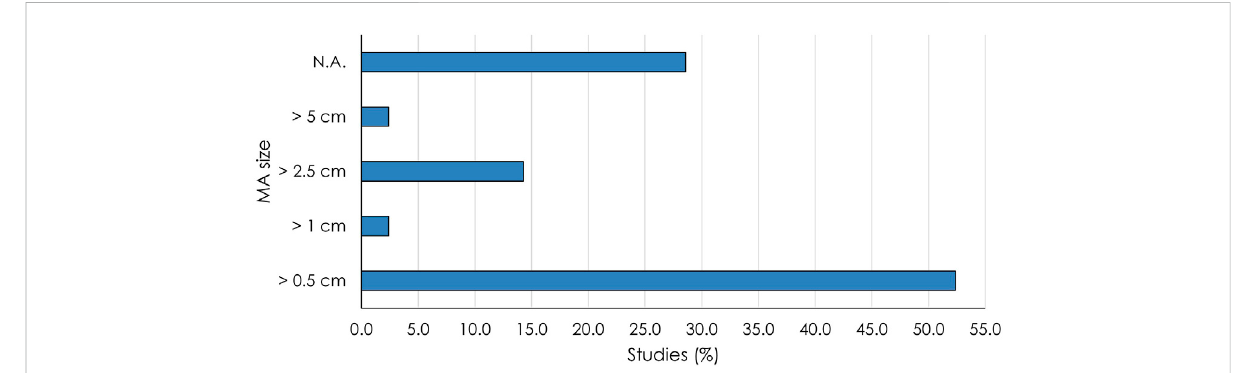
FIGURE 10 Threshold for macroplastic (MA) size adopted in different studies (%). N.A. represents the studies in which the threshold size was not assessed.